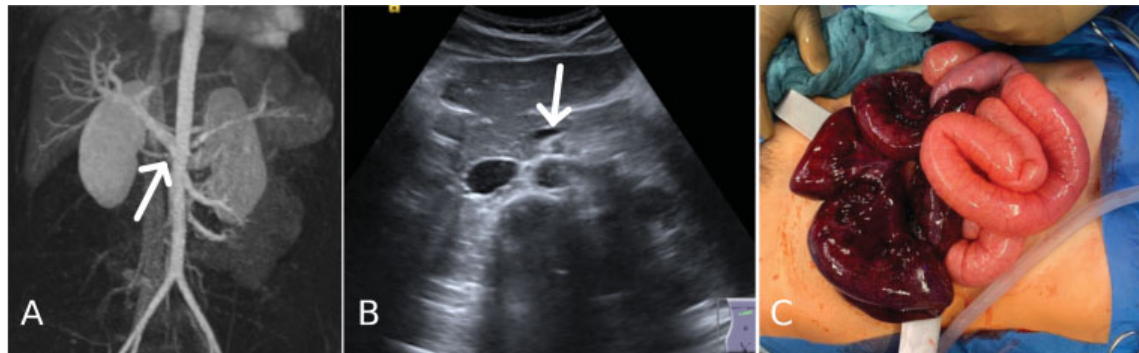
Fig. 2 Contrast-enhanced magnetic resonance angiography demonstrated a slight ventralization of the venous con fl uence in front of the mesenteric artery (arrow) ( A ). B-mode ultrasound showed a slight clockwise ventralization of the superior mesenteric vein (arrow), which normally lies to the right of the superior mesenteric artery ( B ). Midline laparotomy revealed a 360 degrees-volvulus involving (cid:1) 115cm of ileum up to 10cm proximal of the ileocecal valve with marked intestinal ischemia. The cecum and colon were in their normal anatomical position (not shown) ( C